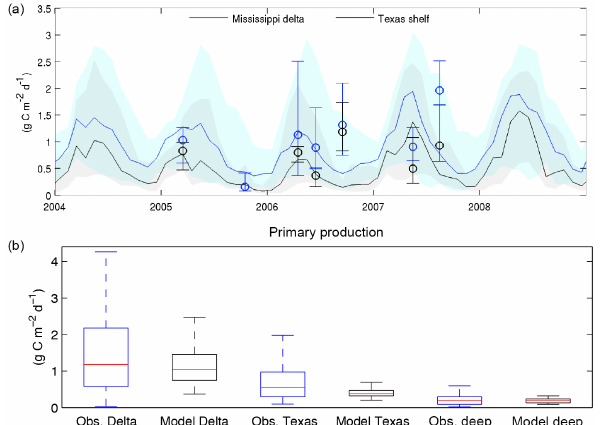
Figure 6. (a) Modeled and observed time series of primary produc- tion for the Mississippi delta and Texas shelf; gray and light blue shades depict the model production ranges for the Mississippi delta and Texas shelf, respectively; (b) box plots of primary production in the Mississippi delta, Texas shelf, and deep Gulf region derived from observations and model (GoMBio) outputs during spring– summer. Red lines, bottom and top edges of the boxes, and whiskers represent the median, interquartile interval, and non-outlier range,